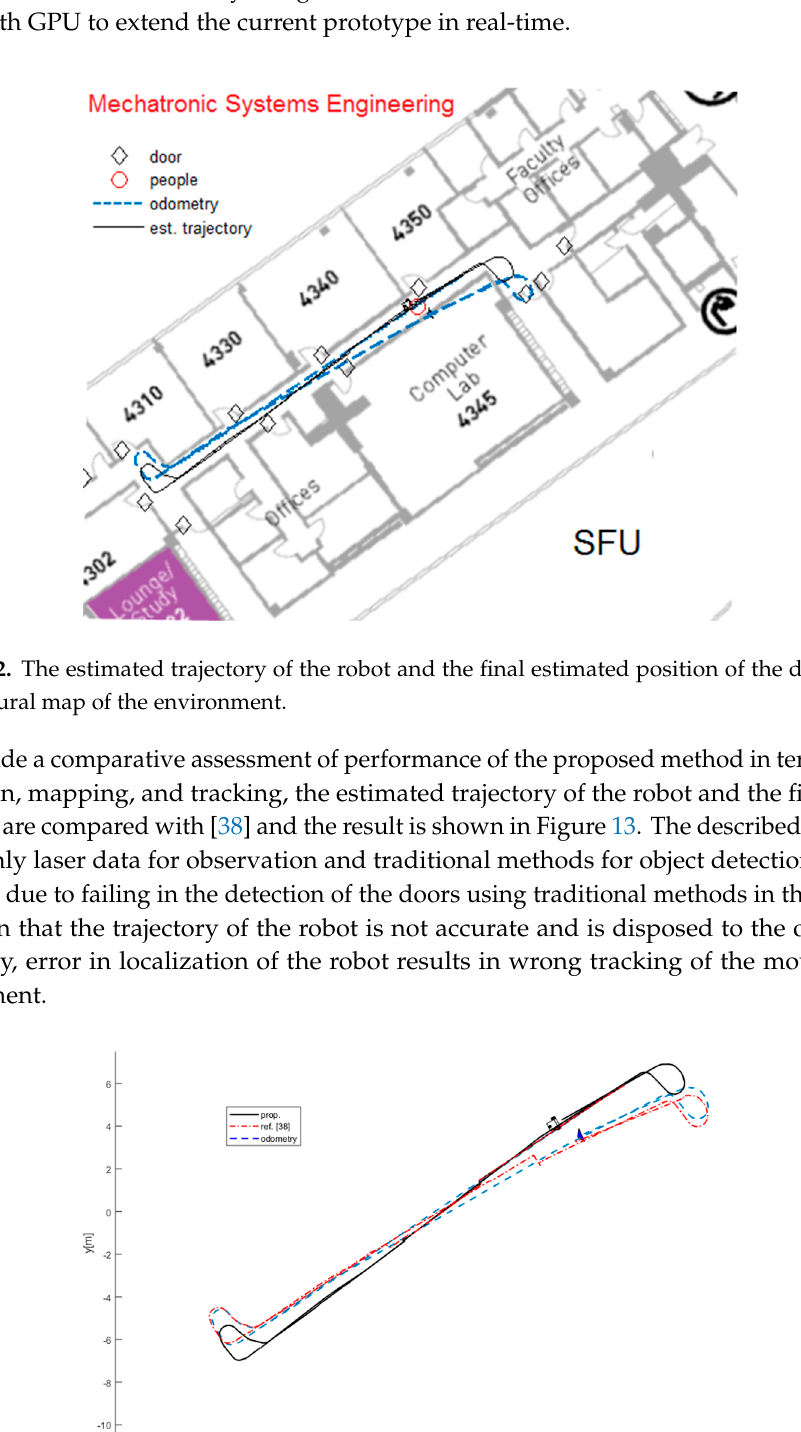
tracks along with the estimated position of doors.